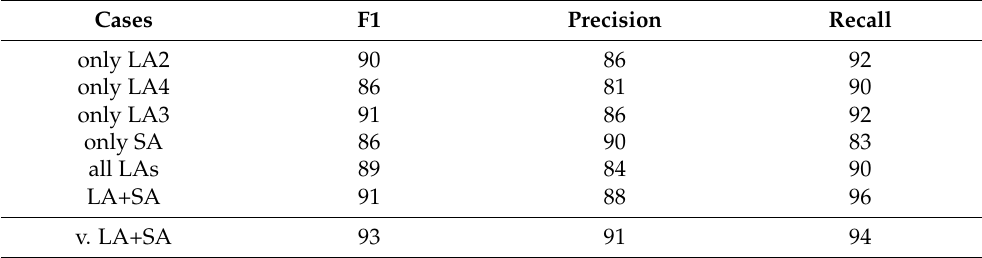
Table 3. The performance of the best model on the test sets. The last row shows the result on the validation set when the long-axis views were combined with the short-axis views.